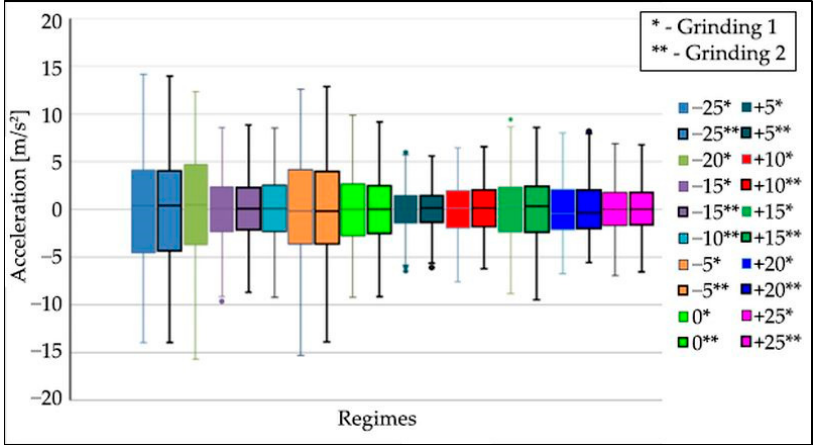
Figure 11. Boxplots of the acceleration of the oscillation in the tested modes on the ruler in the “ y ‐ axis” direction, grinding wheel speed—1907.2 [rpm], basic speed (regime 0) for regulating wheel— 20.2 [rpm], workpiece speed—254 [rpm], ruler distance—13 [mm].